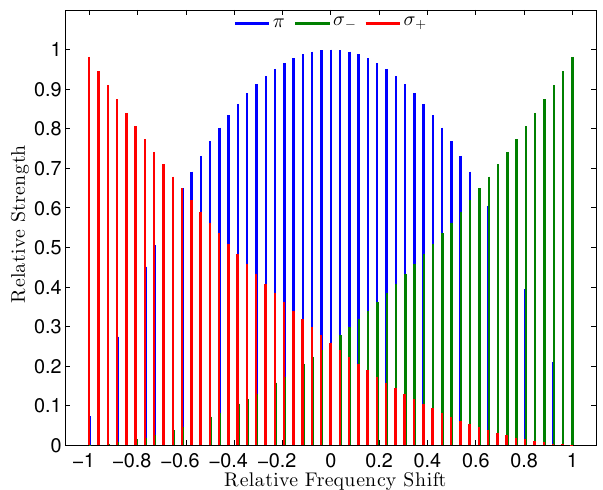
Figure 4. Example of Zeeman pattern for the 53GHz 16 O 2 line that is observed by TEMPERA. The colors represent the Zeeman component as indicated by the legend. The plot is renormalized on both axes as described in the